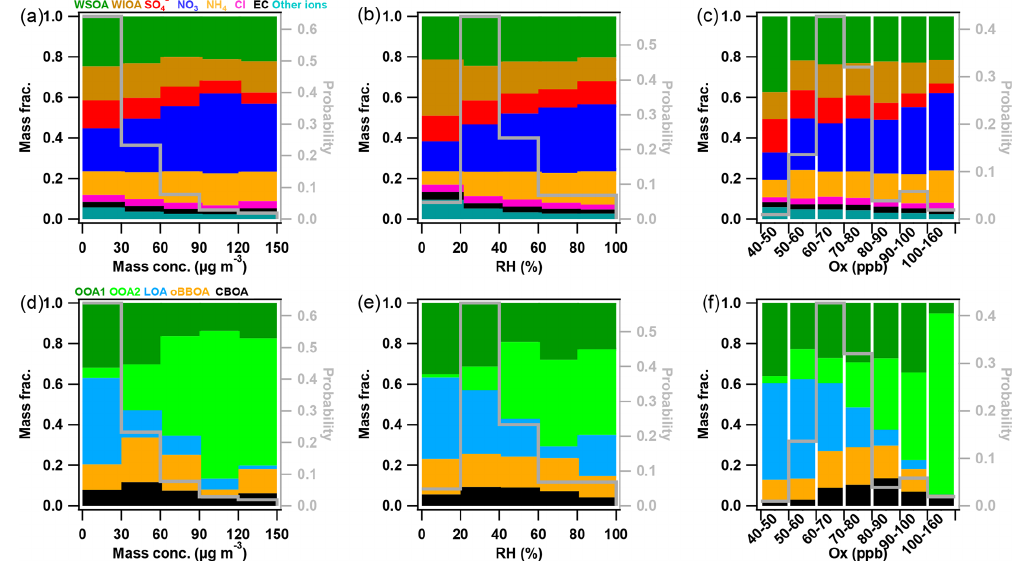
Figure 8. Mass fractions variations of aerosol species in PM 2 . 5 as well as OA factors in WSOA as a function of (a,d) mass concentration, (b,e) RH, and (c,f) O x